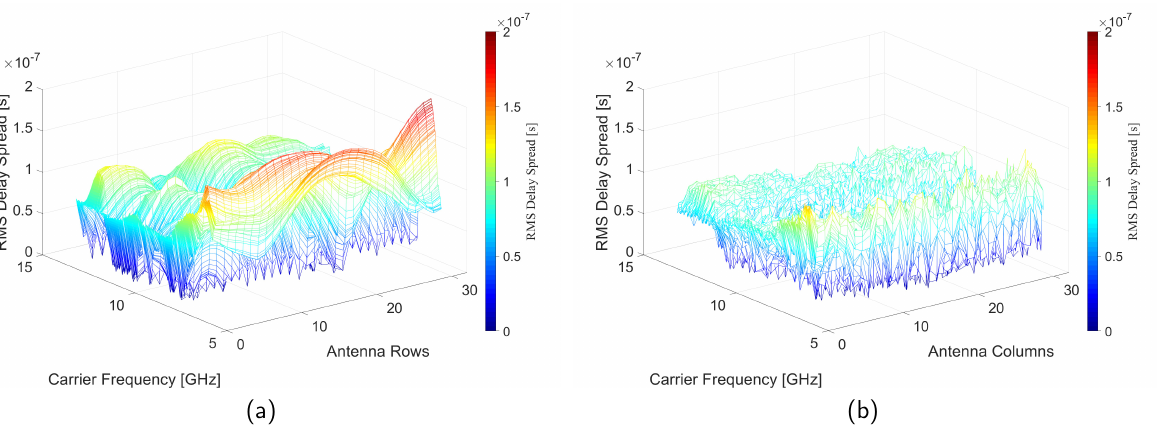
Figure 11. The RMS delay spread versus carrier frequency and antenna elements at Position 2. ( a ) The RMS delay spread in different rows. ( b ) The RMS delay spread in different columns.